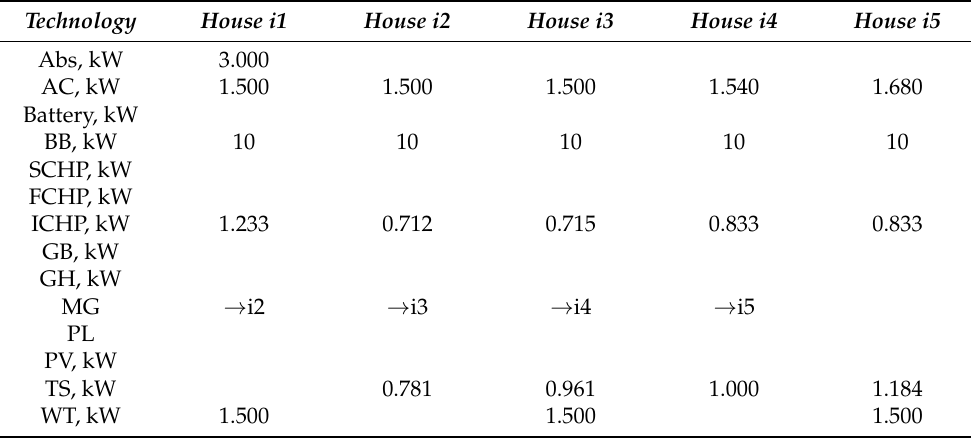
Table 6. Integrated DER technologies installations for the Baseline network.